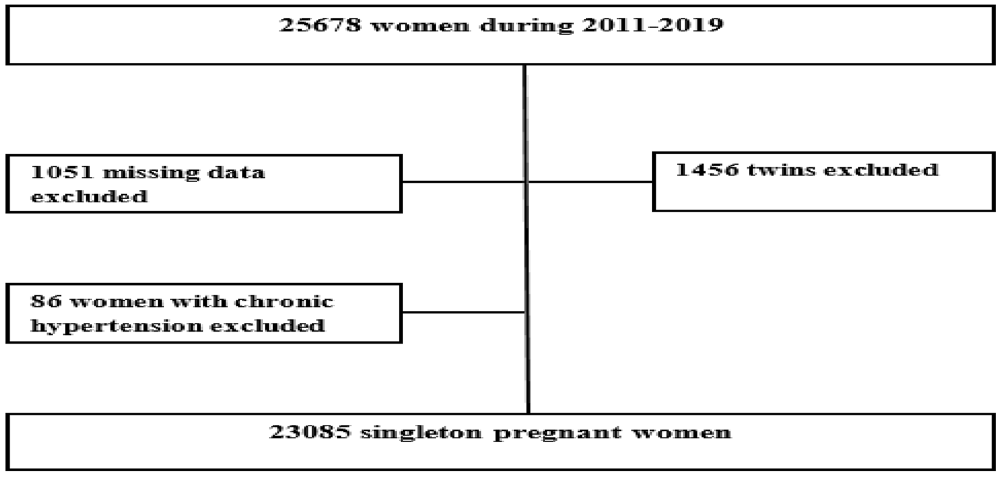
Figure 3. Flow chart of study